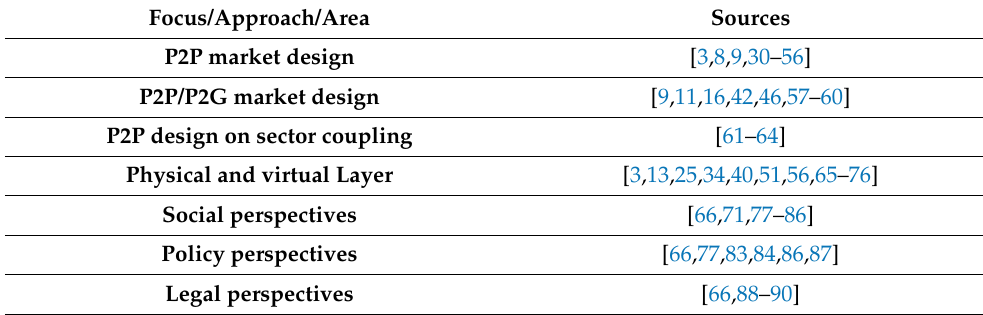
Table 1. Cluster of papers with a focus on theoretical